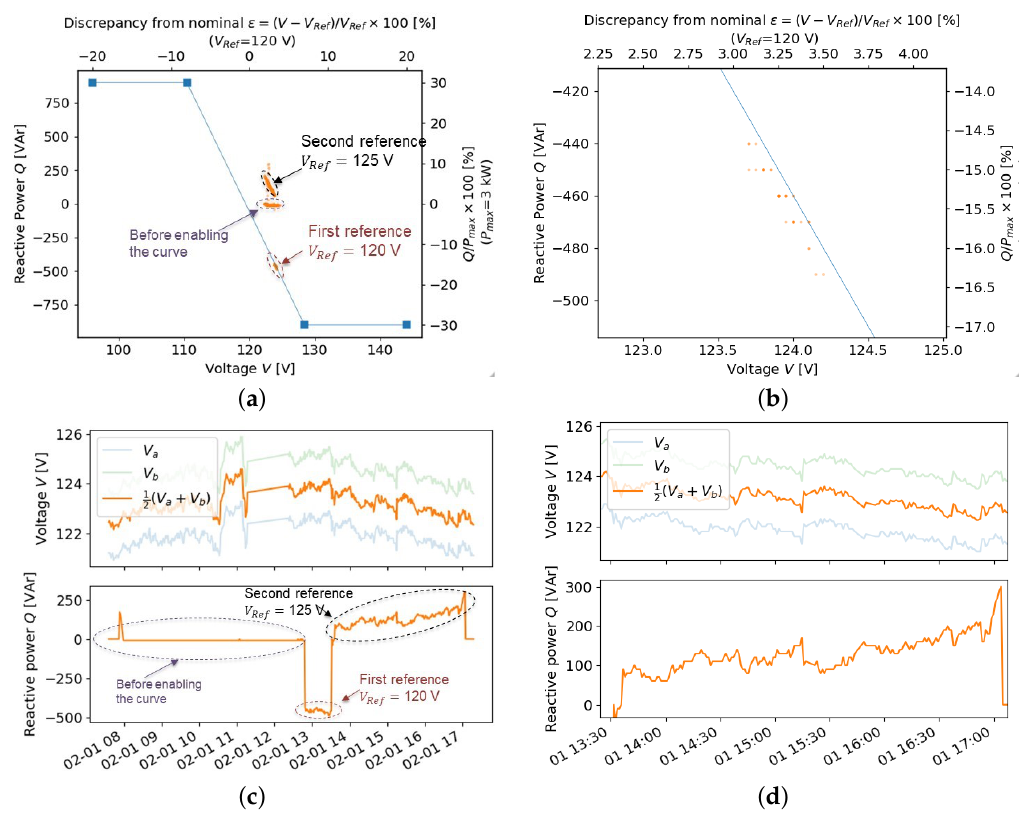
Figure 18. Setting up Volt-VAr curve: ( a ) Volt-VAr space close-up near 125 V reference; ( b ) second cluster close-up; ( c ) time domain; ( d ) time domain